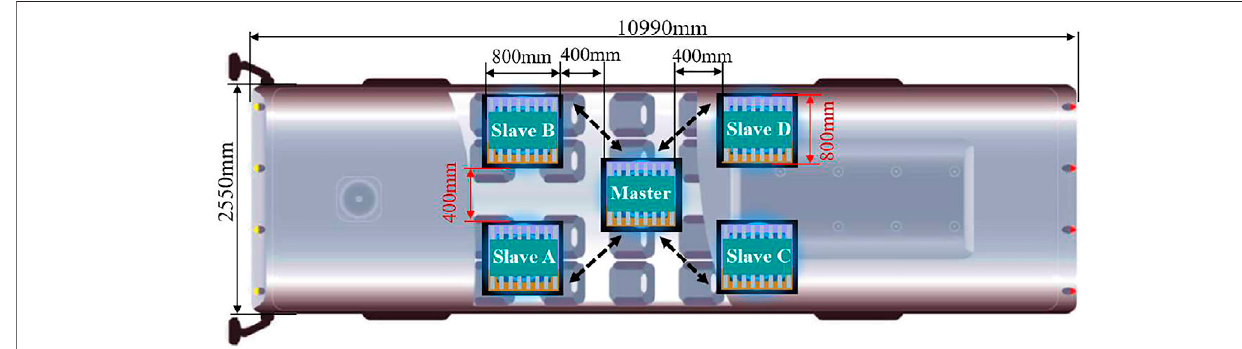
FIGURE 11 | Design of coils ’ layout under the vehicle.